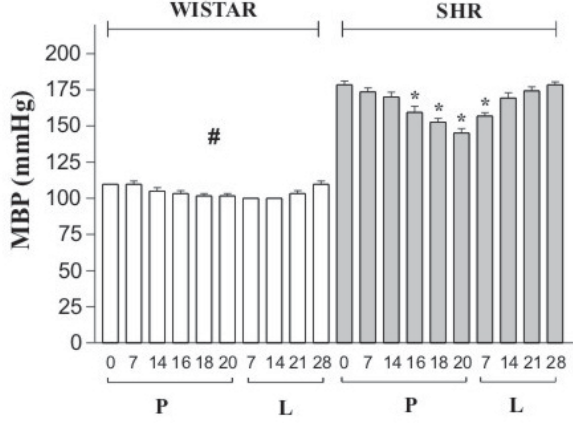
FIGURE 1- Mean blood pressure (MBP) of Wistar rats (n=8) and SHR (n=15) during the period of pregnancy (P) and lactation (L). The bars represent the mean ± SEM of the rats BP values measured on different days. * Significant difference (p<0,05) between BP values of SHR in 0 day of pregnancy and others days of pregnancy and lactation. # significant difference between BP values of Wistar rats and SHR in every experiments performed (p<0.01 by